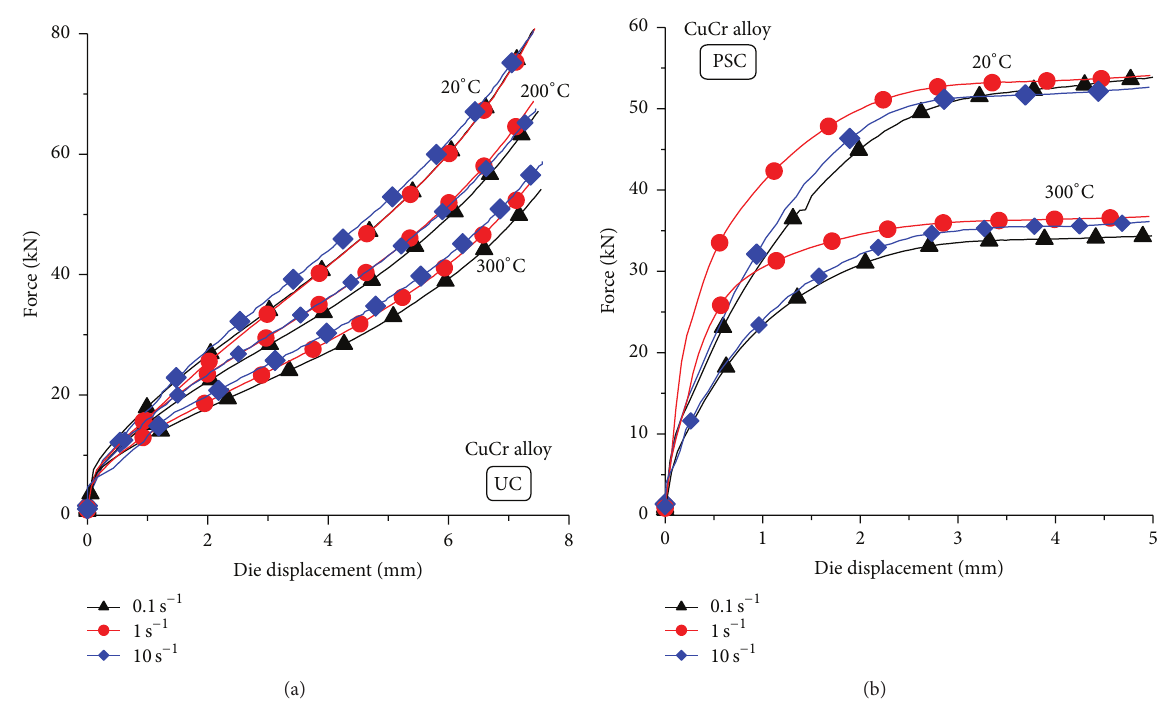
Figure 8: Loads measured in the UC tests (a) and the PSC tests (b) for the CuCr